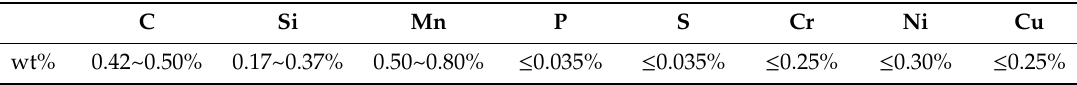
Table 4. Chemical constituents of AISI 1045 steel.